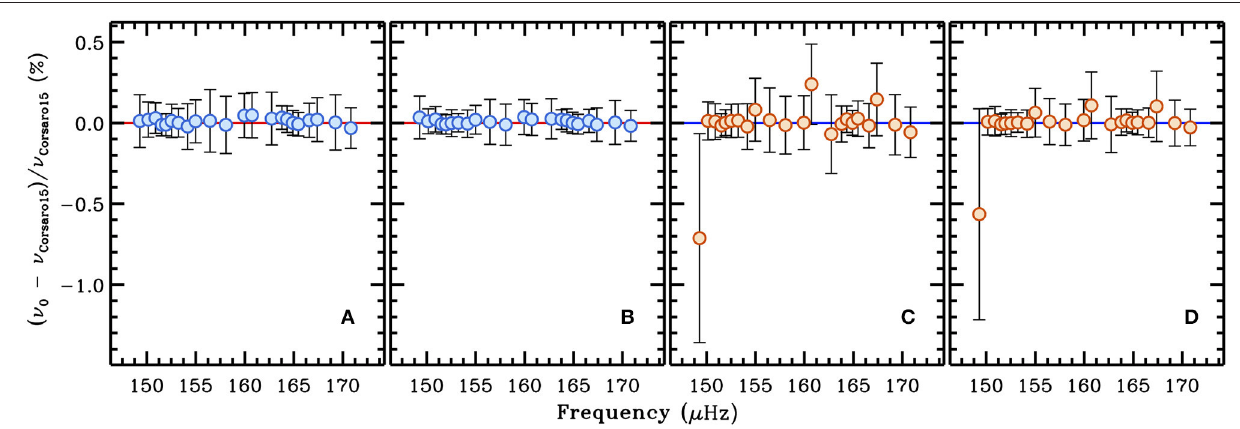
FIGURE 2 | Comparison between the oscillation frequencies extracted from DIAMONDS using the multi-modal approach ( ν 0 ) and those published by C15 ( ν Corsaro15 ). The values are reported in percentage of deviation with respect to the literature values. The uncertainty error bars obtained with the new approach are also overlaid for each oscillation frequency, after they were rescaled by ν Corsaro15 . The horizontal lines at ( ν 0 − ν Corsaro15 ) /ν Corsaro15 = 0 % denote the perfect matching. The panels from left to right depict the result obtained by considering four different methods to extract the frequencies from the counts histogram: (A) using a symmetric frequency range for each local maximum, with an extent on each side of the maximum that is the minimum found between the two distances going from the maximum to the adjacent midpoints from the next and previous maxima (or the edge of the total frequency range) on the right and left side respectively. The final frequencies are computed as the sampling mean from the sampling falling in the selected range of each local maximum, while the corresponding uncertainty is the standard deviation from the same sampling used to compute the mean; (B) using the same symmetric ranges as (A) but this time performing a weighted mean and weighted standard deviation using the nested iteration of each sampling point as a weight; (C) using an asymmetric frequency range, built with the distances between the maximum and the adjacent midpoints from the next and previous maxima (or edge of the total frequency range) on the right and left side respectively. The mean and standard deviation of the selected sampling of the range are used as in (A) to compute the final frequency and uncertainty estimates from each local maximum; (D) same as the case (C) but this time using a weighted mean and standard deviation as done for the case (B)